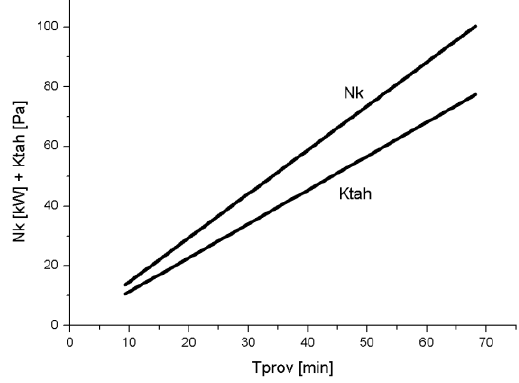
Figure 2. Dependence of the boiler power output Nk (kW) and stack draft Ktah (Pa) to the working time Tprov (min), for the boilers with power output up to 100 kW.